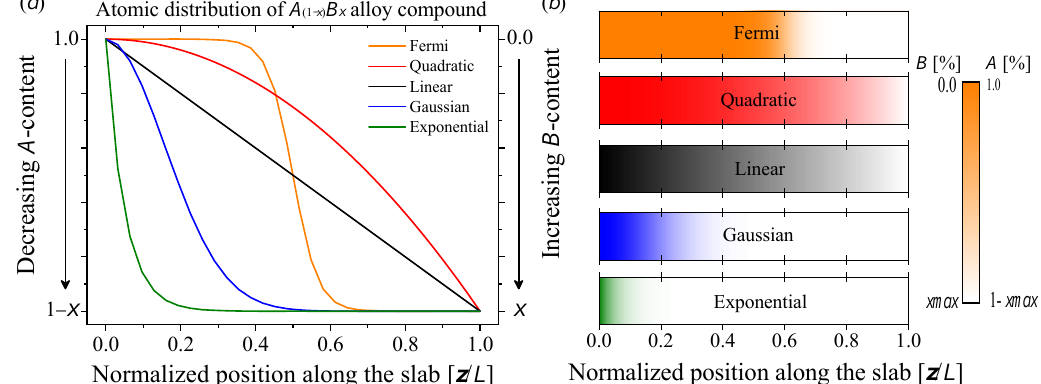
Figure 1. ( a ) Contour plot of the thermal conductivity ( k ) of Si (1 − x ) Ge x alloy as a function of Ge content ( x ) and temperature (green contour). Four different “cuts” of the contour taken, as indicated by the colored lines ( b ), two vertical cuts at T = 400 and 600 K (dotted magenta and dotted grey lines, respectively), and ( c ) two diagonal cuts (solid orange and dotted blue lines). ( b ) Thermal conductivity of Si (1 − x ) Ge x as a function of Ge content at a fixed temperature T = 400 and 600 K (dotted red and dashed black lines, respectively). ( c ) Thermal conductivity as a function of temperature of a Si (1 − x ) Ge x slab where the Ge content varies linearly along the slab between x = 0 (pure silicon, Si) and x = 0.5 (Si 0.5 Ge 0.5 ). It should be noted that this spatial dependence creates different k curves when the temperature reservoirs are changed. ( d ) Schematic representation of the continuous alloy distribution along the heat flux axis ( z ) of a hypothetical slab of alloy of length L for the cold-hot (forward) and hot-cold (reverse) configurations.